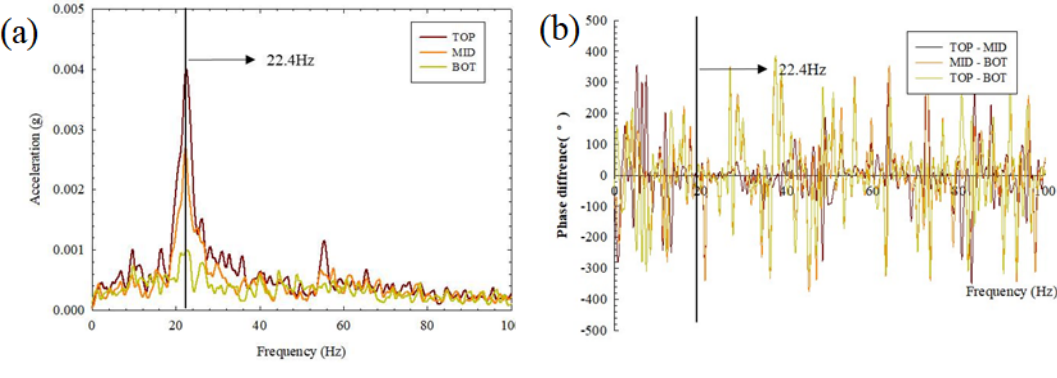
Figure 10. Results of the impact vibration load test in the pier length direction. ( a ) Natural frequency of the second mode and ( b ) phase difference of the second mode.